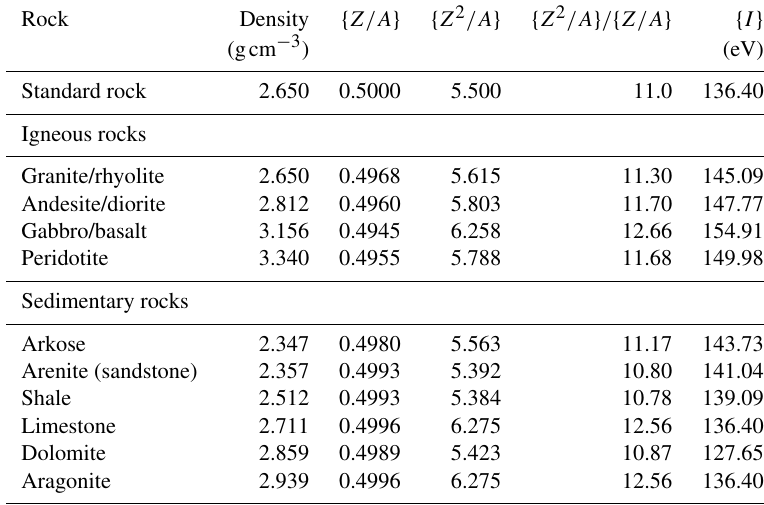
Table 1. Physical parameters of the 10 studied rock types and of standard rock. Rock Density Standard